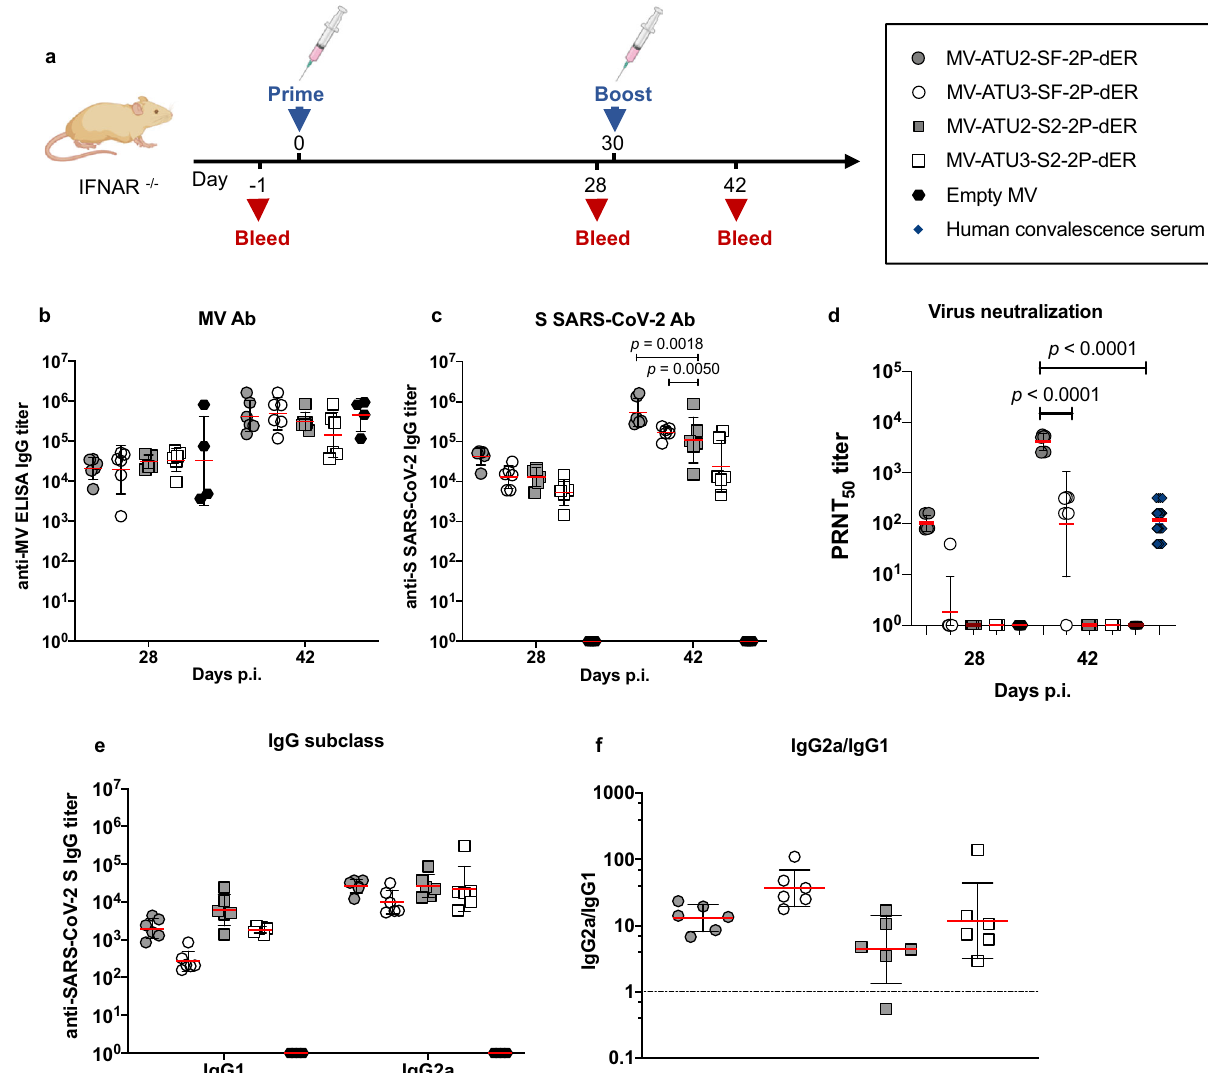
Fig. 3 Induction of humoral responses by prime-boost vaccination. a Homologous prime-boost of IFNAR − / − mice ( n = 6 or n = 4 for the empty MV control) immunized intraperitoneally with 1 × 10 5 TCID 50 of the indicated rMV at days 0 and 28. Sera were collected 28 and 42 days after immunization and assessed for speci fi c antibody responses to b MV antigens or c S-SARS-CoV-2 S. The data show the reciprocal endpoint dilution titers with each data point representing an individual animal. d Neutralizing antibody responses to SARS-CoV-2 virus expressed as 50% plaque reduction neutralization test (PRNT 50 ) titers. e IgG subclass of S-speci fi c antibody responses in mice 4 weeks after the fi rst immunization. f Ratio of IgG2a/IgG1 responses. Data are represented as geometric mean with line and error bars indicating ±geometric SD. Statistical signi fi cance was determined by two-way ANOVA with Tukey ’ s multiple comparisons